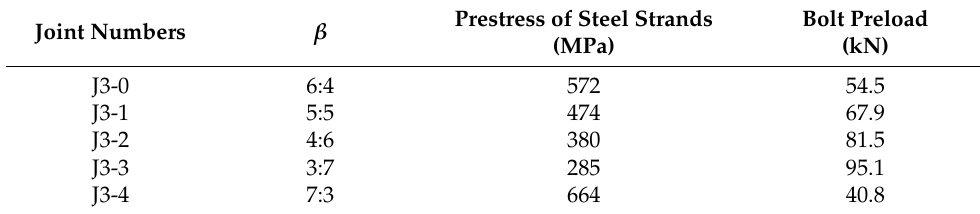
Table 7. Parametric settings of J3-0~J3-4.